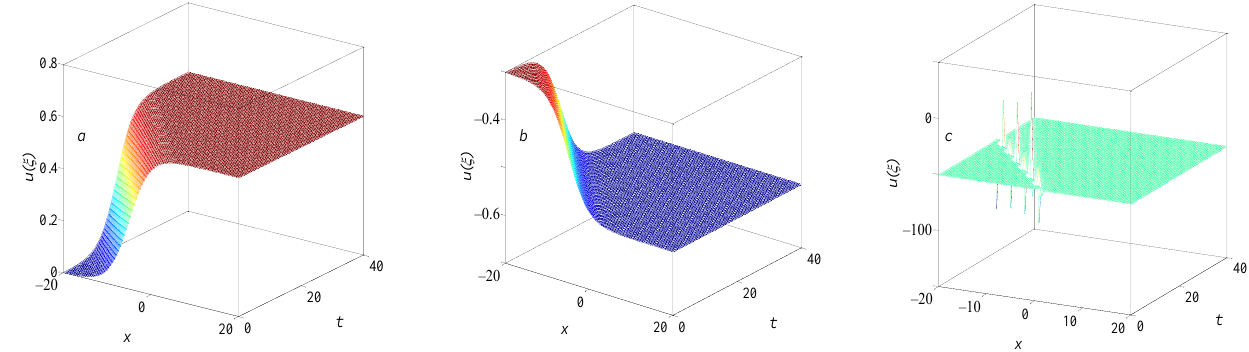
Figure 6. Three-dimensional plots of the solutions of Equation (48) when η = 1 and ε = 1; ( a ) δ = 1 Figure 6 . Three-dimensional plots of the solutions of Equation (48) when 𝜂 = 1 and 𝜀 = and k = − 0.0472; ( b ) δ = 1 and k = 0.0472; and ( c ) δ = − 3 and k = 1 ; ( a ) 𝛿 = 1 and 𝑘 = −0.0472 ; ( b ) 𝛿 = 1 and 𝑘 = 0.0472 ;and ( c ) 𝛿 = −3 and 𝑘 = 0.0472 .